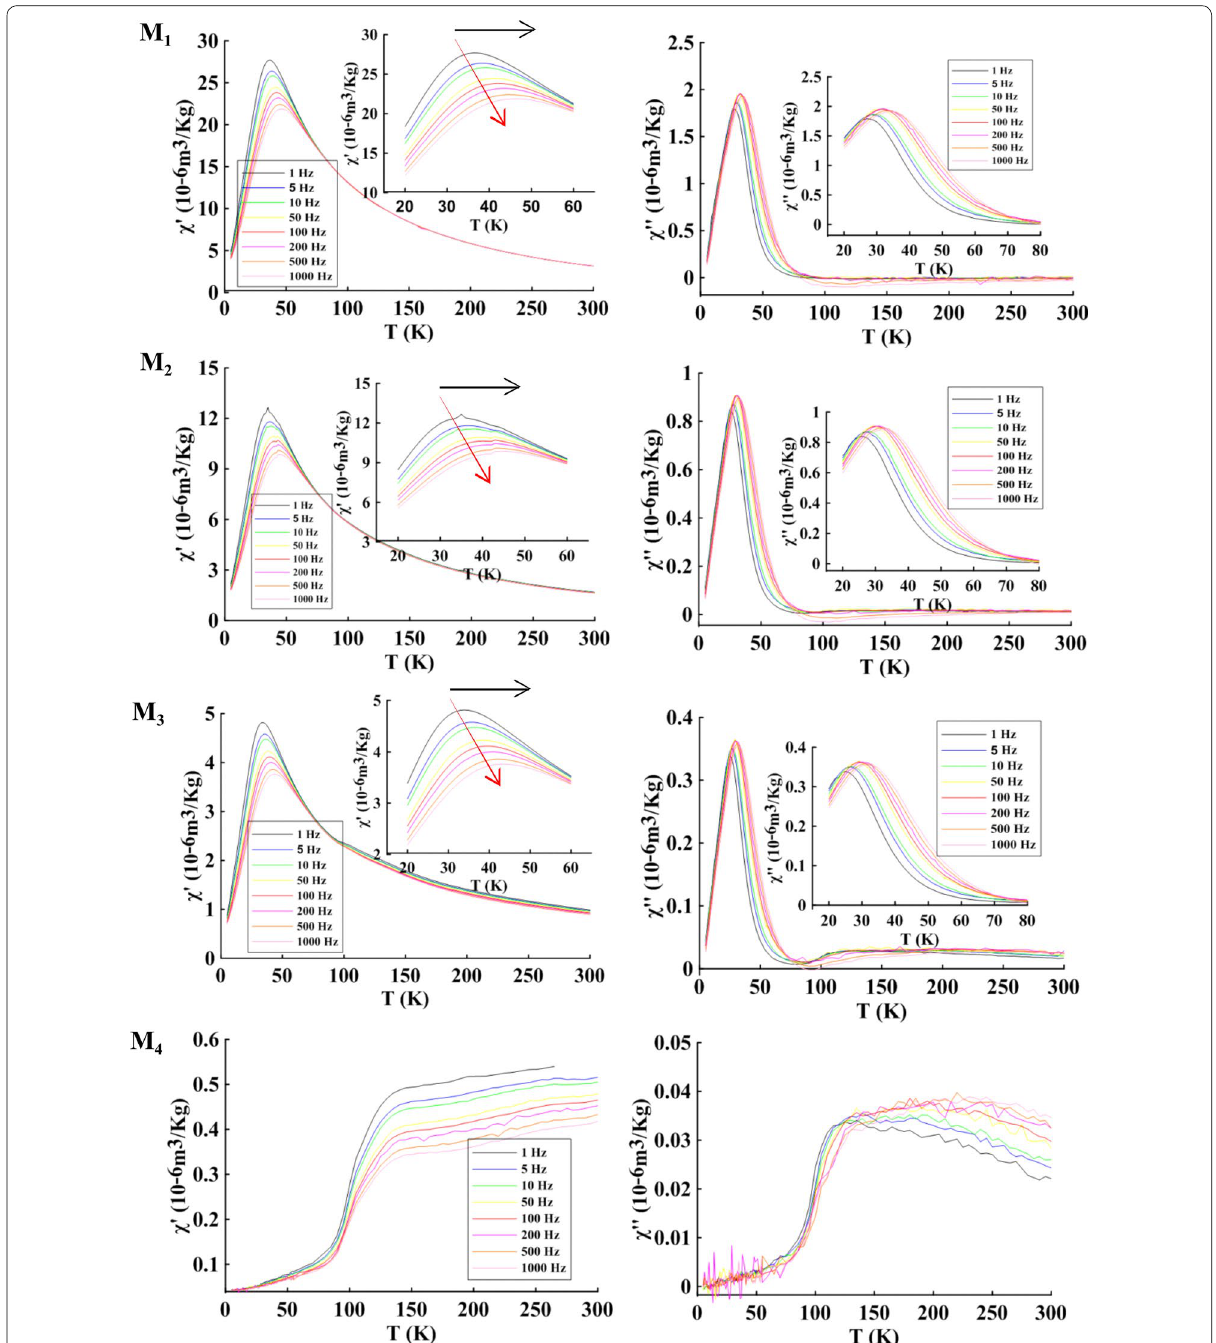
Fig. 7 Curves of real and imaginary components, χ ′ and χ ″ , of the AC susceptibility versus temperature. Samples were measured at frequencies of 1 Hz, 5 Hz, 10 Hz, 50 Hz, 100 Hz, 200 Hz, 500 Hz, 1000 Hz in a peak AC field of 0.4